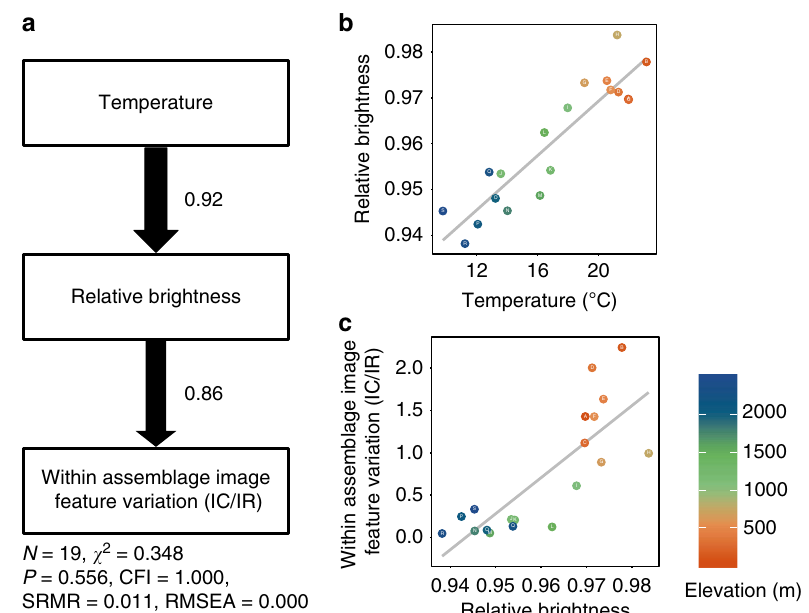
Fig. 5 The relationships among climate, colour traits and within-assemblage image feature variation. a Path diagram of factors in fl uencing within- assemblage image feature variation. The relationships between b mean relative brightness of species at each assemblage and temperature and c relative brightness and within-assemblage image feature variation (IC/IR). Path thickness is proportional to the standardized regression coef fi cient (shown next to the path arrows). Log transformation was applied on the IC/IR for structural equation modelling. Warmer colours correspond to lower elevations, and cooler colours to higher elevations. Source data are provided as a Source Data fi